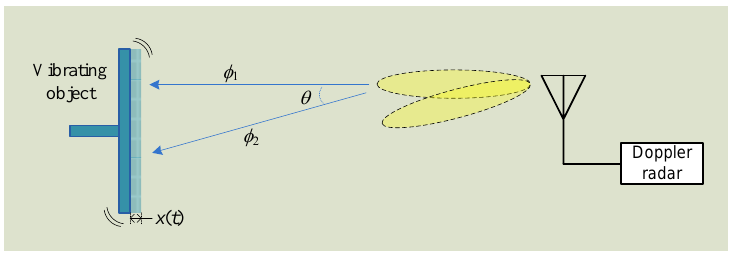
Figure 18. The Doppler radar with beam-steering antenna could radiate the signal to the target in two directions with an angle of θ.